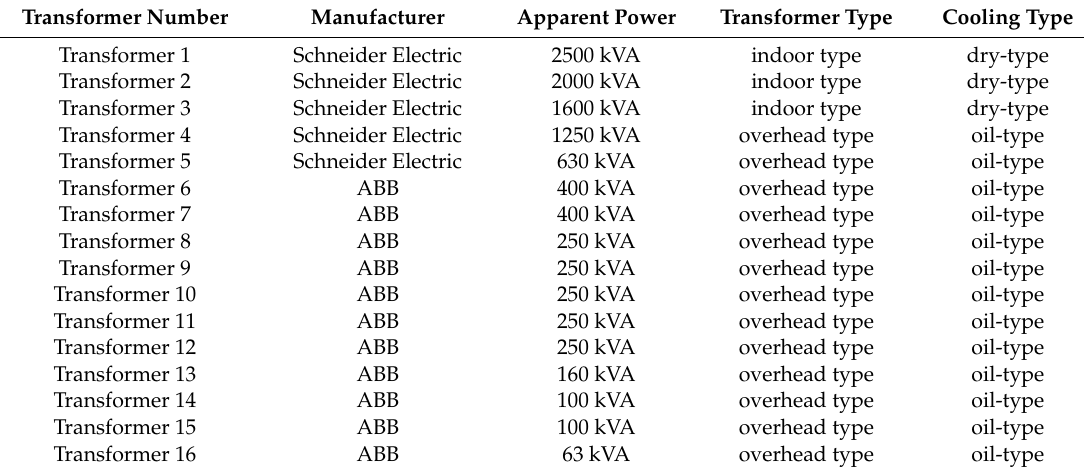
Table 1. List of the transformers under study.